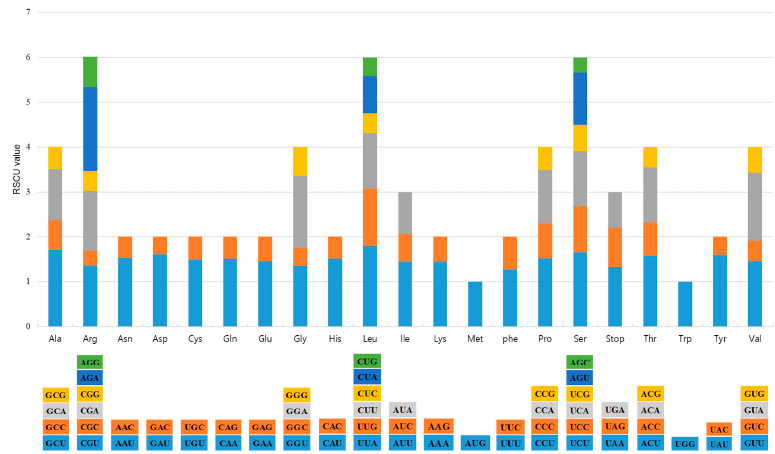
Table 2. Genes present in the CP genomes of A. pseudolaeve Nakai and A. longecassidatum Nakai.